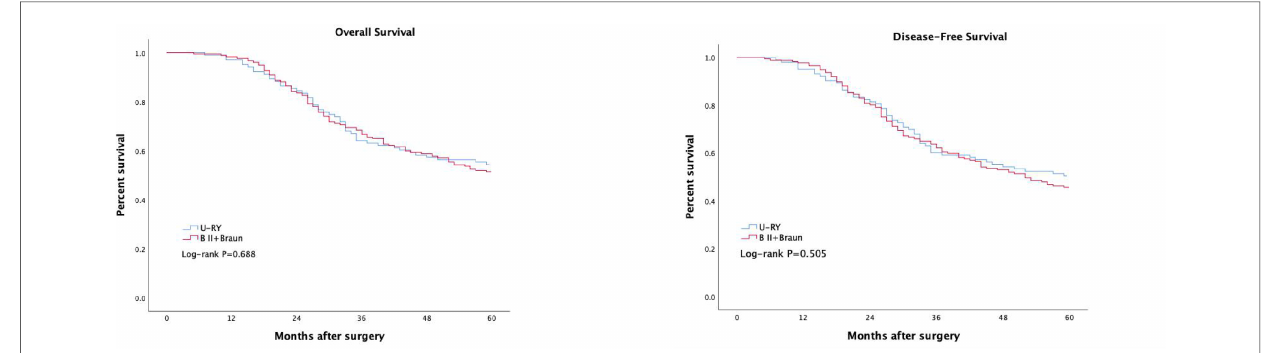
FIGURE 5 Comparison of long-term curative effect between two groups of patients. ( A ) Overall survival, ( B ) Disease-free